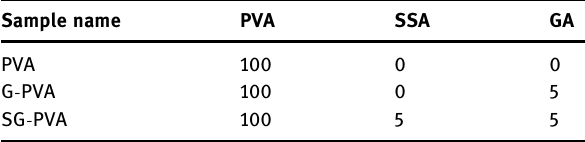
Table 1: Composition of the composite membranes by molar